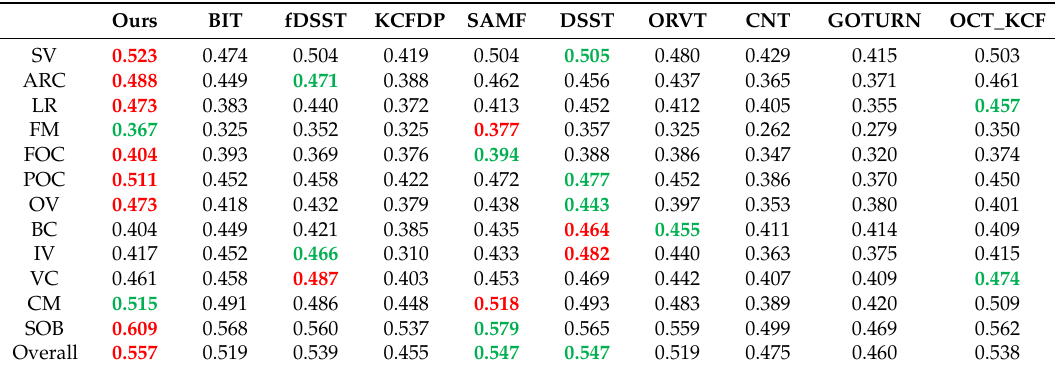
Table 1. Overall precision rates on different attributes, where the entries in red denote the best results and the ones in green indicate the second best.